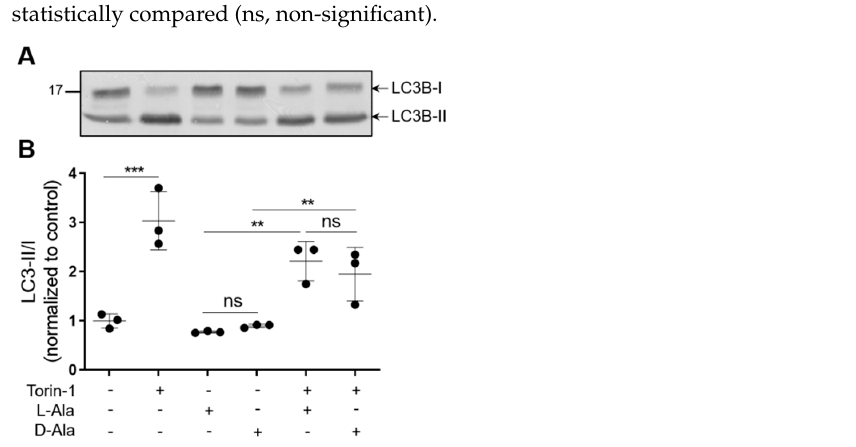
Figure 6. Moderate levels of po-H 2 O 2 do not affect the processing of LC3B-I to LC3B-II. DD-DAO Flp-In T-REx 293 cells were cultured as described in the legend to Figure 3 and pre-incubated or